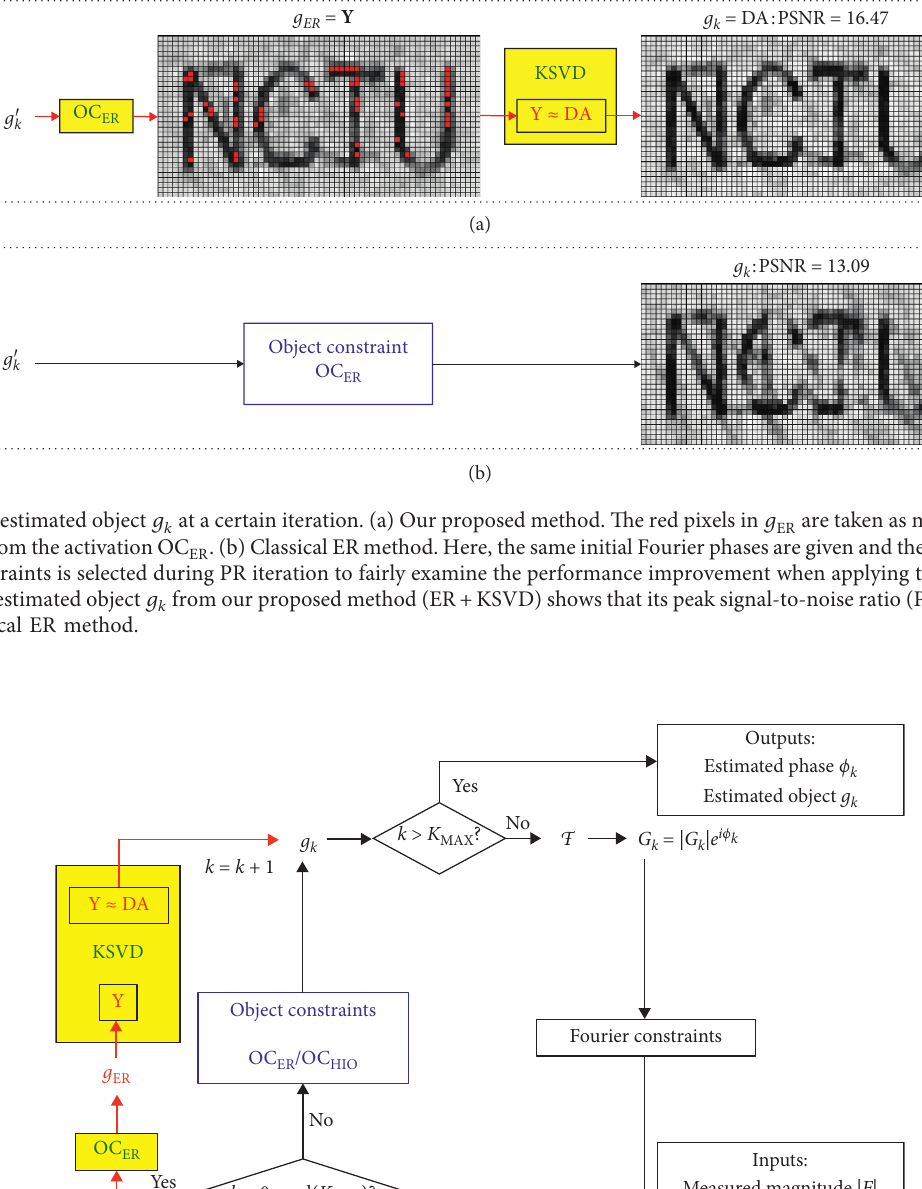
) in the object /OC ER HIO , k , and K are represented by MAX cycle